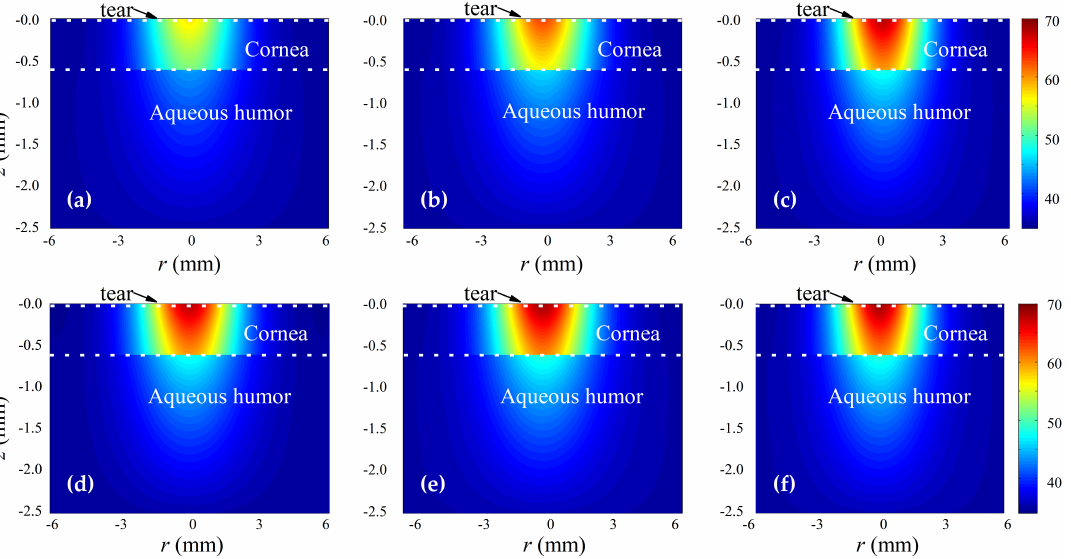
Figure 2. Time-dependent evolution of temperature distributions under terahertz heating with beam radius w 0 = 3mm, power density P d = 0.6W/cm 2 , and exposure time of ( a ) 10 s; ( b ) 30 s; ( c ) 60 s; ( d ) 180 s; ( e ) 300 s; and ( f ) 1200